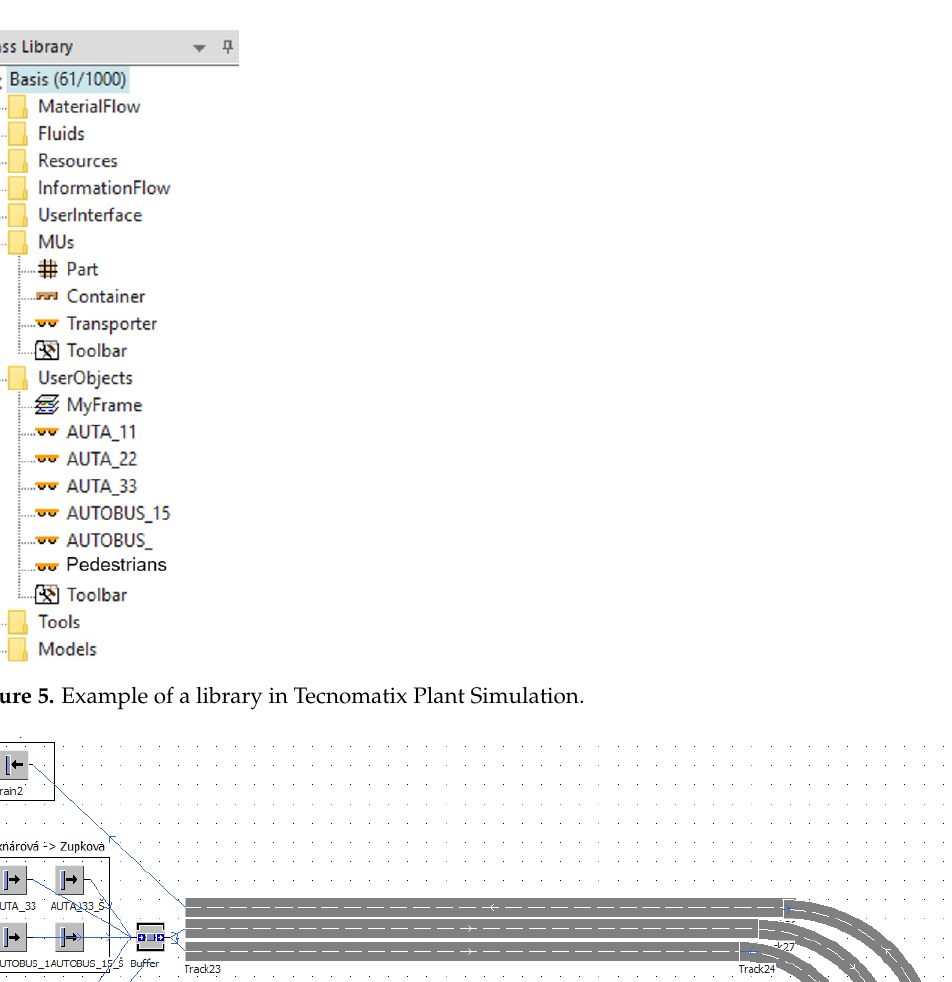
Figure 6. Objects alignment via